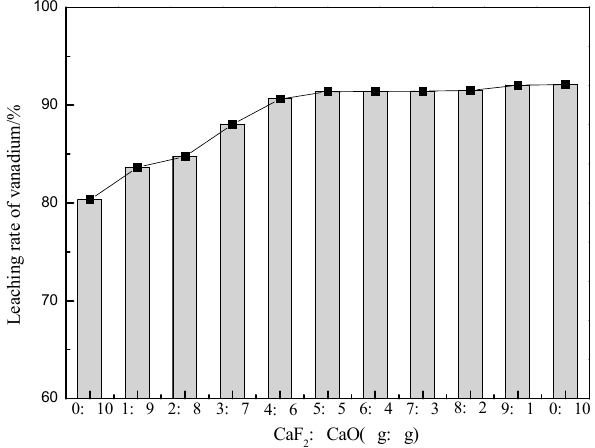
Figure 2. Effect of the CaF 2 /CaO proportion on the leaching rate of vanadium.